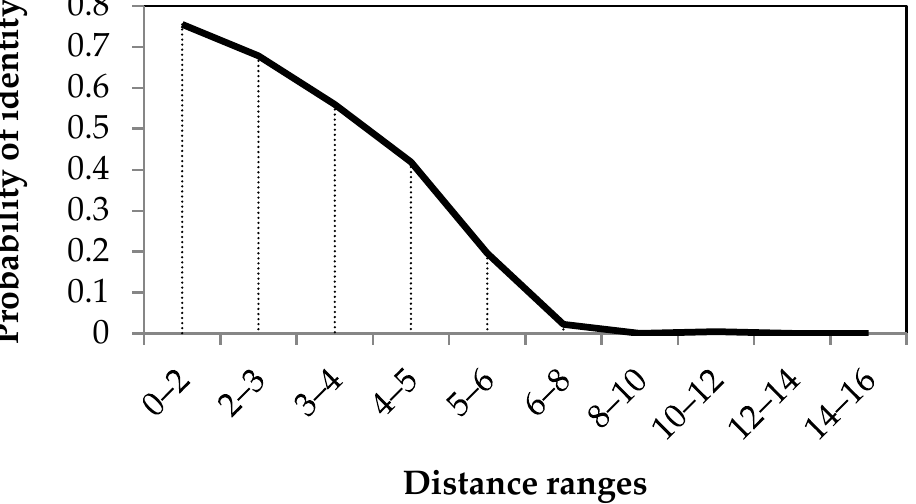
Figure 4. Correlograms of the estimated values of probabilities of genet identity for English holly. Distance classes range from 0 to 16 m with a distance interval of 2 m.